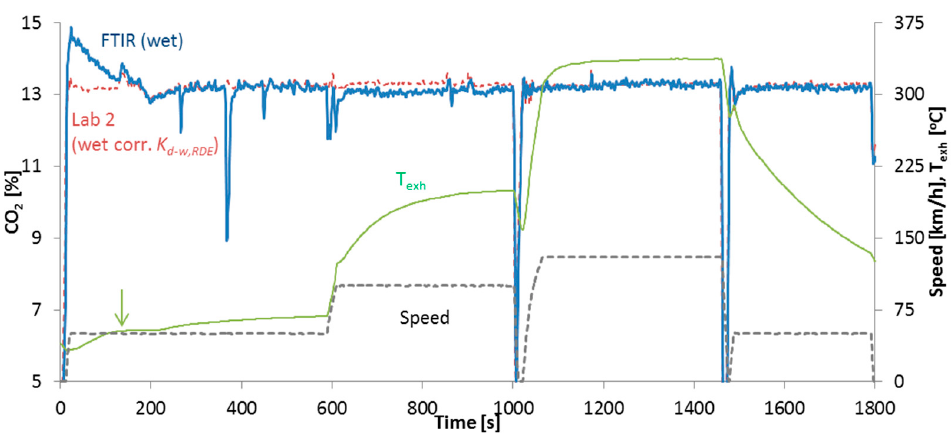
Figure 6. Steady speeds test with G-PFI #2. The arrow shows the time when the temperature reached 53 °C. On the right y -axis, “ T exh ” stands for the temperature of the exhaust gas.